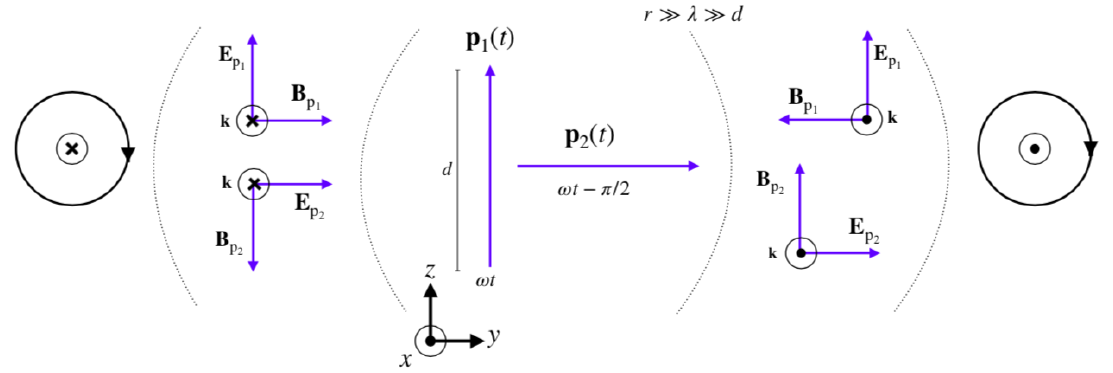
Figure 3. Two oscillating electric dipoles, labelled p 1 ( t ) and p 2 ( t ) , oscillate along the z and y axes, respectively, with a phase difference of π /2. The far-field pattern in the + x direction is identical to that produced by the electric-magnetic dipole configuration in Figure 2, but has opposite polarisation in the − x direction: the net helicity flux in the yz plane is